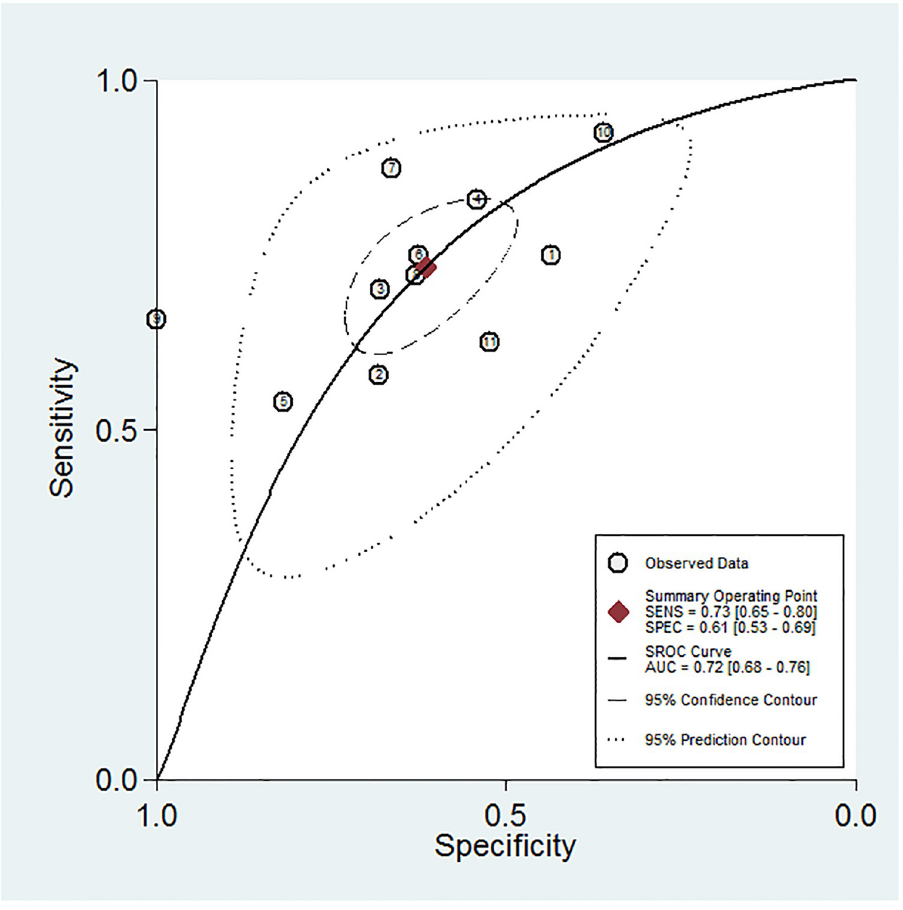
Fig 4. Summary receiver operating characteristic graph for the included studies. AUC = area under curve; SENS = sensitivity; SPEC = specificity; SROC = summary receiver operating characteristic.